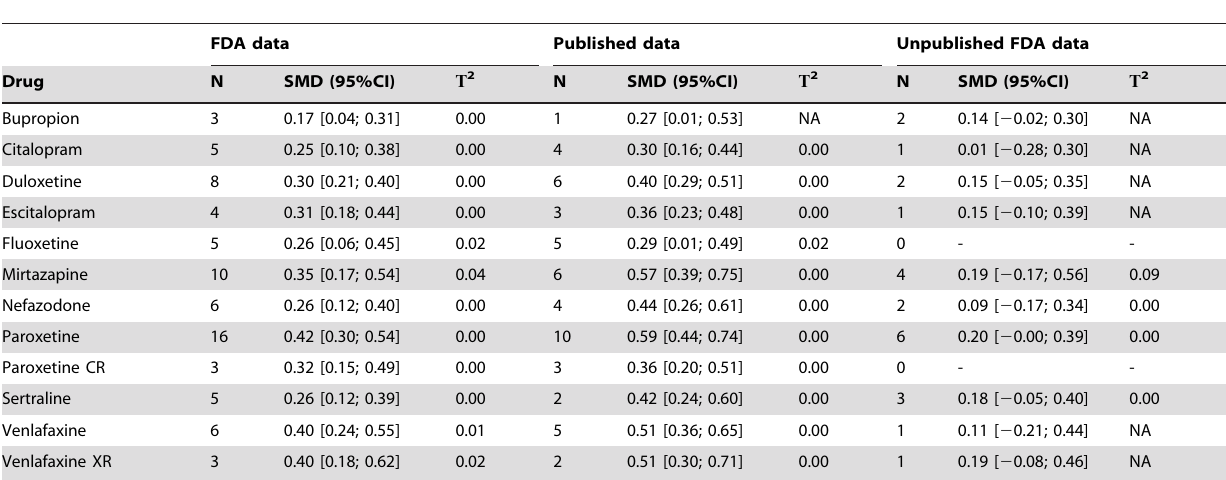
Table 1. Summary effect sizes for the 12 comparisons of each antidepressant agent and placebo.